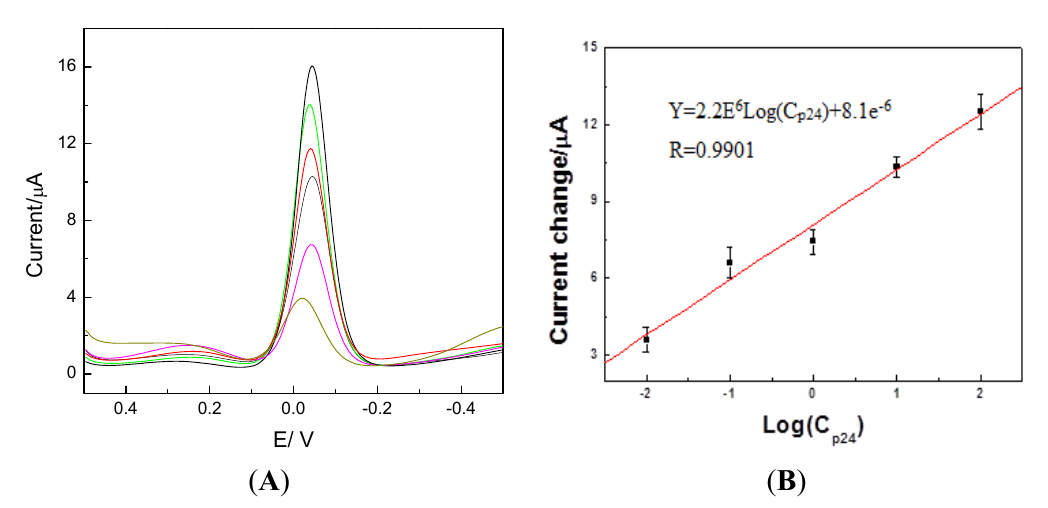
Figure 6. ( A ) Differential pulse voltammetric (DPV) curve. ( B ) Calibration plot of the immunosensor towards different concentrations of